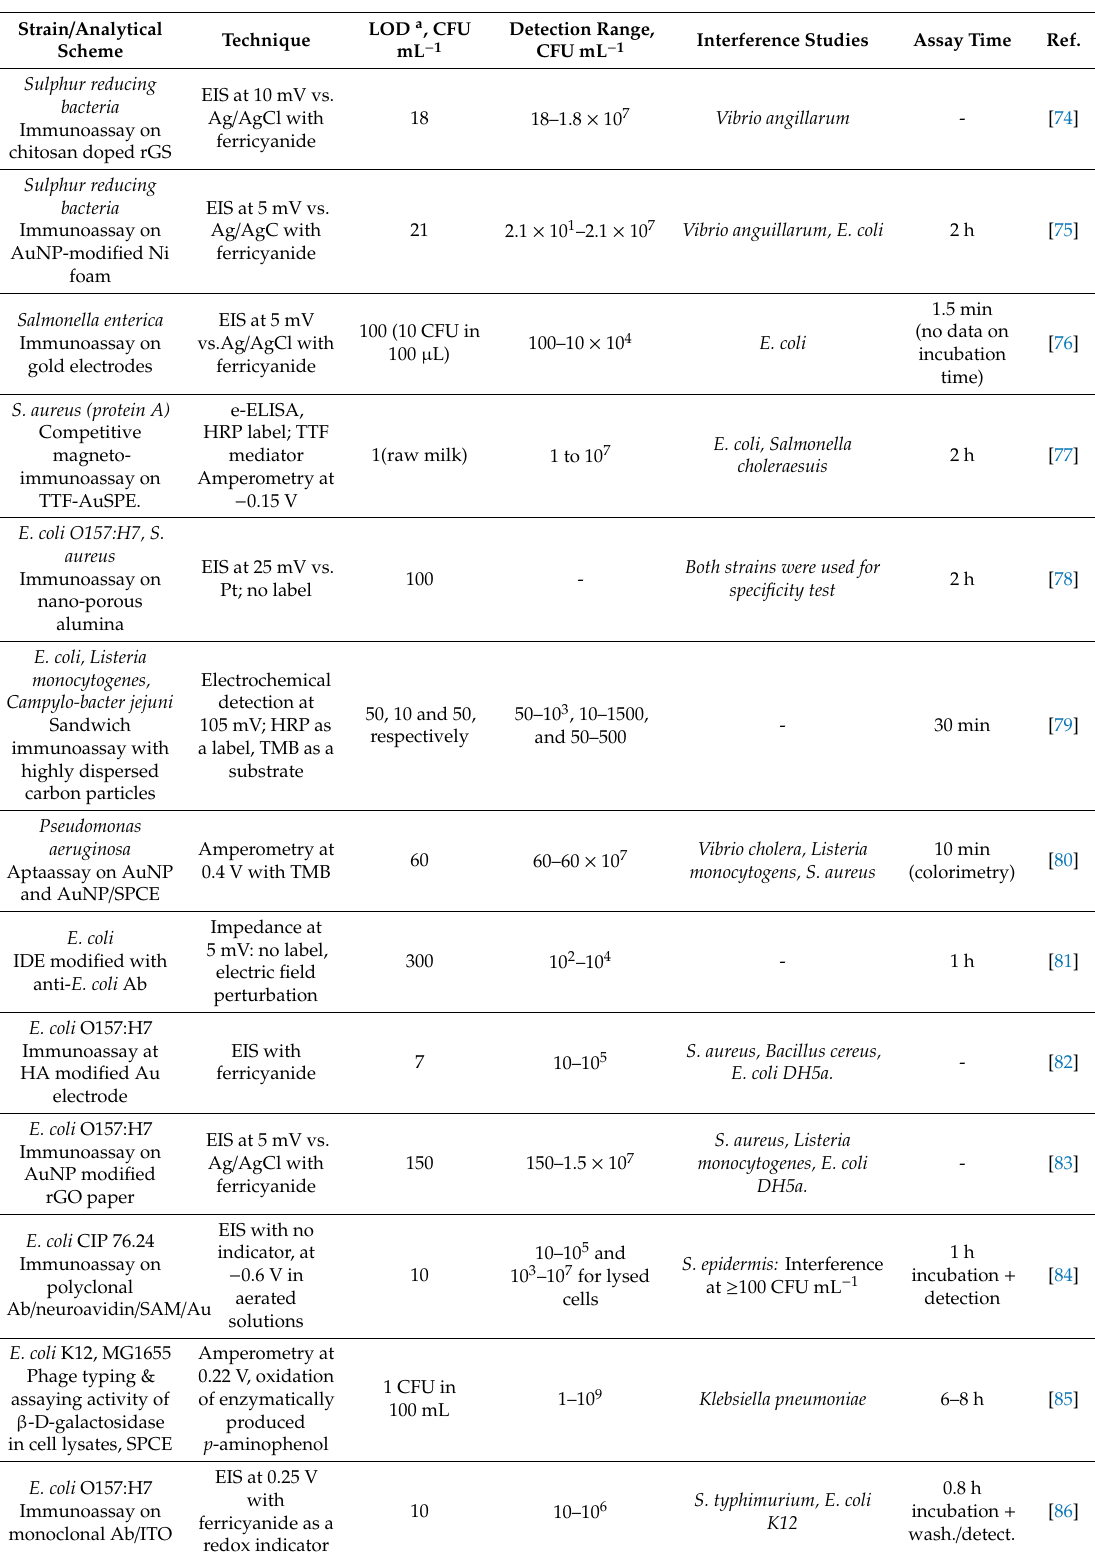
Table 3. Selected examples of ultrasensitive and / or specific sensors for bacterial cells based on electrochemical immunoassay